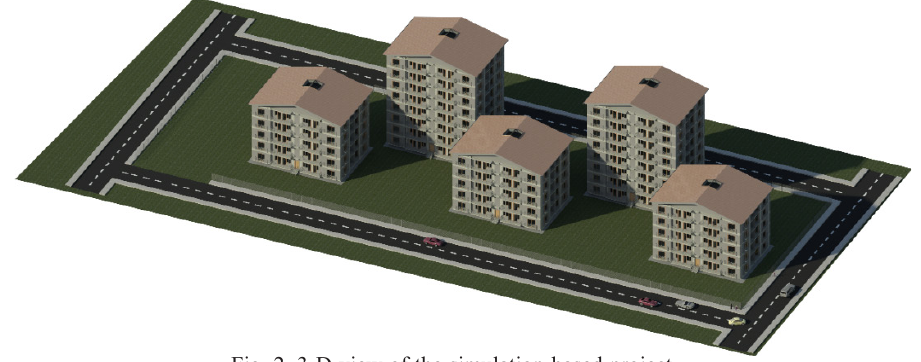
Fig. 2. 3-D view of the simulation-based